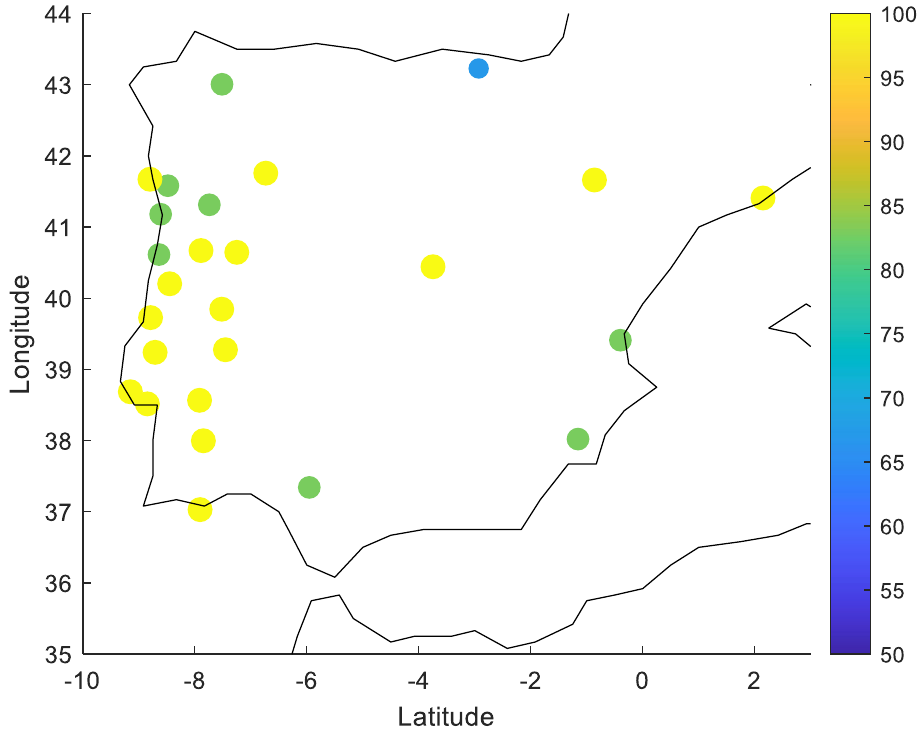
Figure 5. Average percentage of time for the May–October period that 850 hPa wind speed di ff erences, future minus historic, are